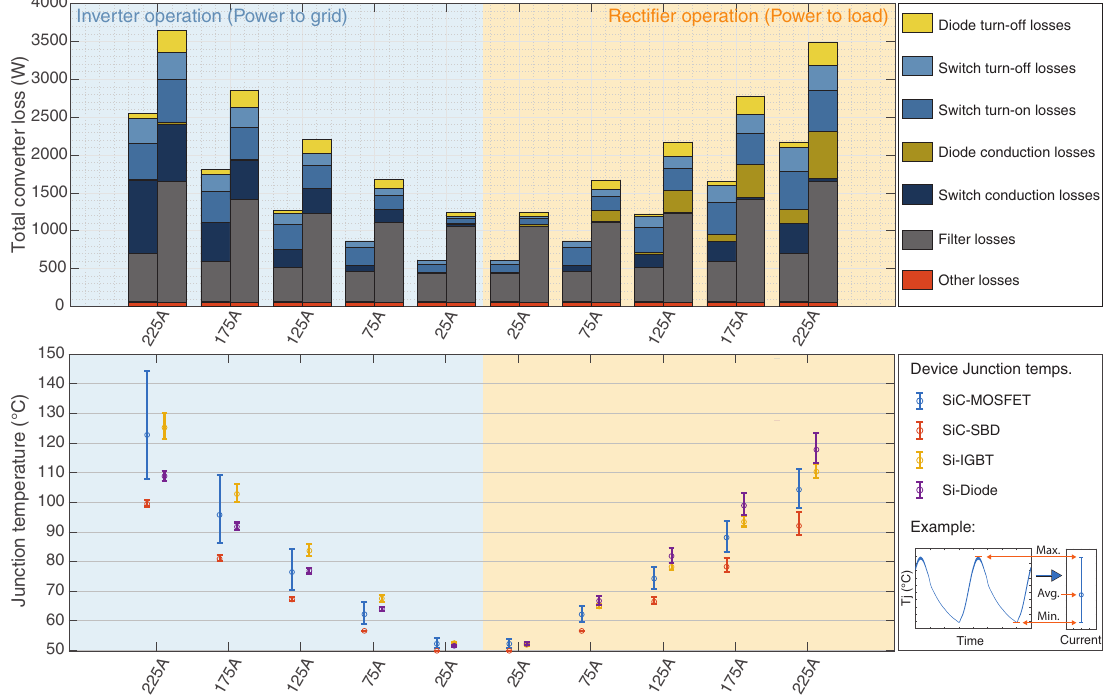
Figure 14. Converter loss distribution and junction temperature behavior for both designs in both modes of operation (Cos( φ ) = [–1, 1] and M = 1.15) as a function of current. ( Top ) Converter loss distribution; SiC-MOSFET converter losses and Si-IGBT converter losses depicted in the left and right bar for every current, respectively. Other losses comprise gatedriver loss, heatsink fan loss and DC-Link loss. ( Bottom ) Junction temperature oscillations and average values for all devices in their respective modules; junction temperatures were adjusted to be displayed below their corresponding loss bars instead of over the current for better